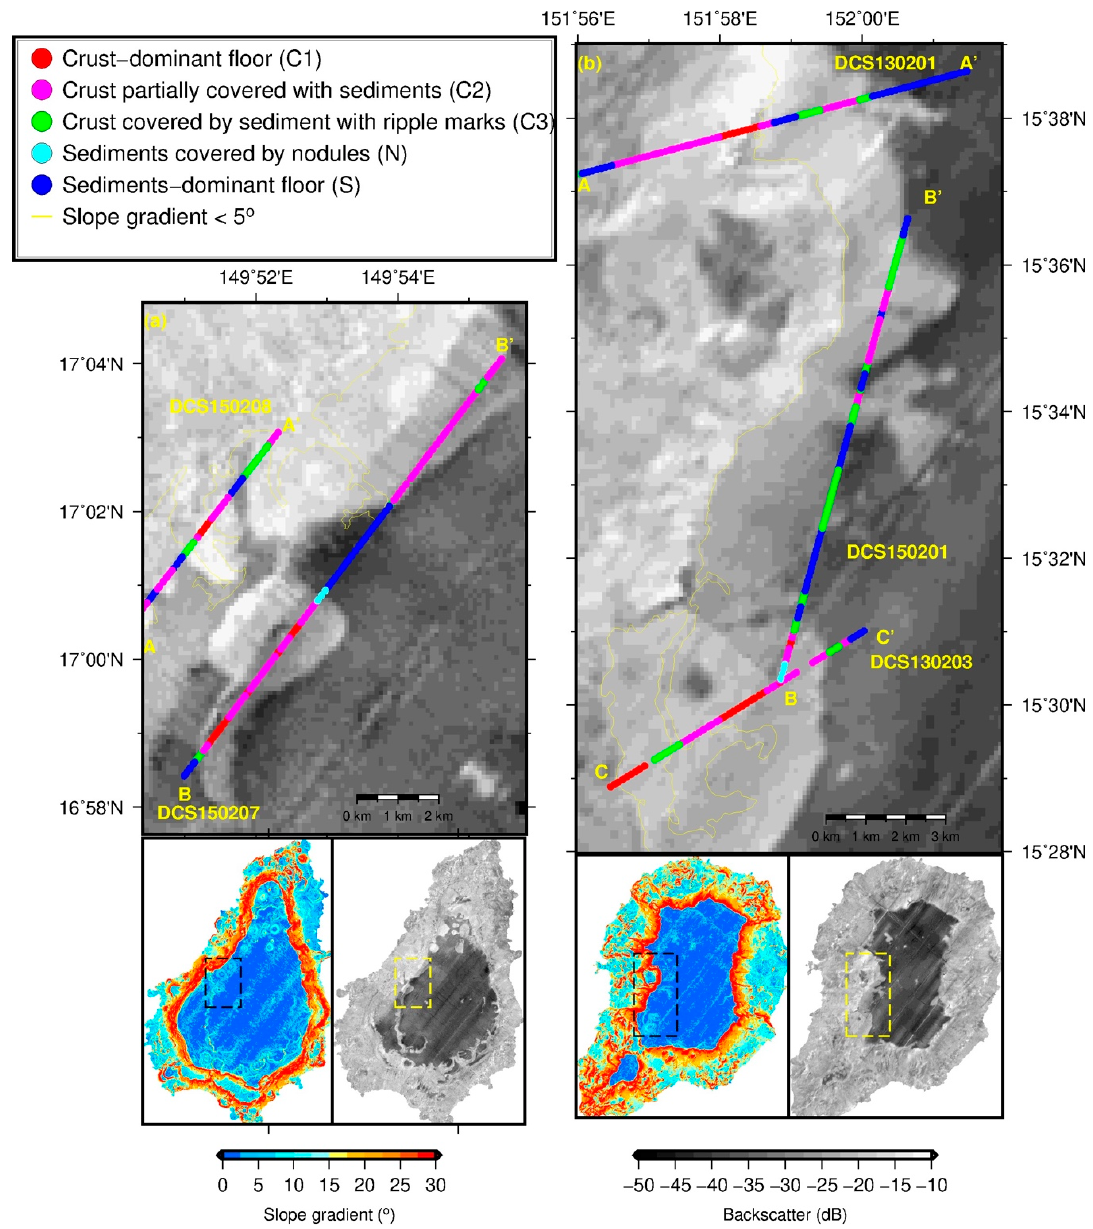
Figure 7. MBES backscatter maps showing distribution of the seabed types within the upper flanks and summit in Type 1 seamounts: the enlarged areas of ( a ) OSM 9-1 and ( b ) OSM 7. Yellow dashed contours indicate summit areas with gradients of <5°. The two lower panels show slope gradient (left) and acoustic backscatter (right) maps, corresponding to OSM 9-1 and OSM 7, respectively. However, crust-covered bedrock with sediments is predominant in the center and edges of